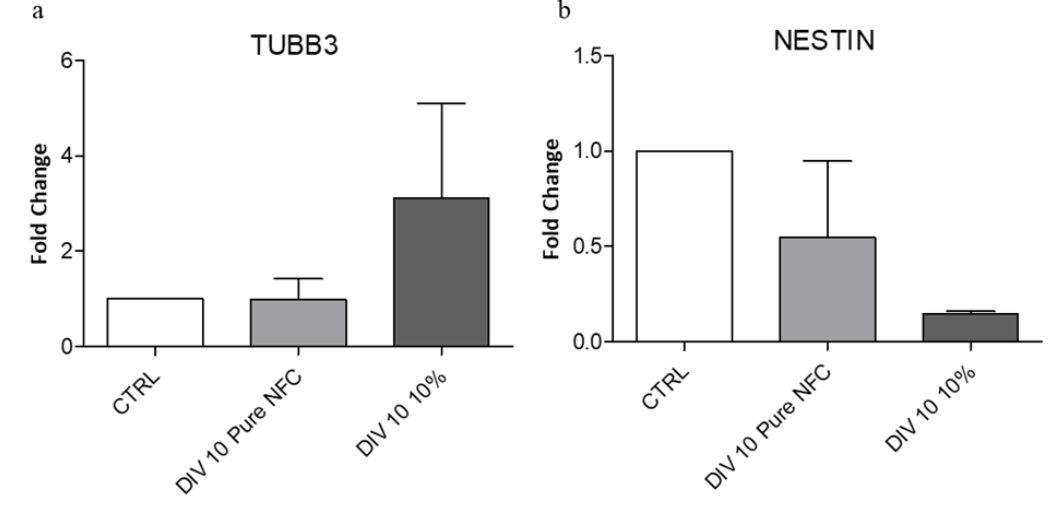
Figure 6. ( a ) TUBB3 expression, a mature neuron marker, increased when cells were cultivated on conductive ink. ( b ) NESTIN expression, an immature neuron marker, decreased in cells cultivated on conductive ink.